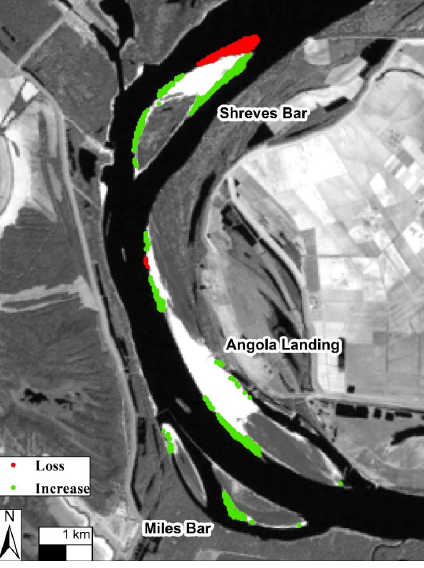
Figure 3. False color images (band 432) showing bare soil (white) and vegetated areas (red) of three large channel bars near Tarbert Landing of the Mississippi River on 2 January 2011 ( A ); 26 May 2011 ( B ); and 1 October 2011 ( C ).